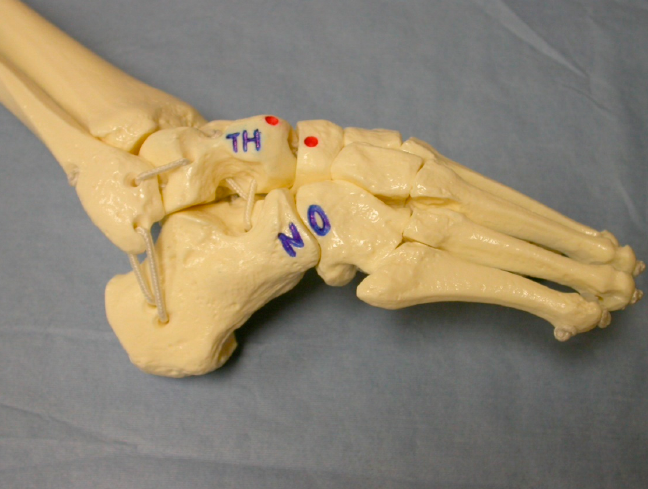
Figure 2. Ponseti foot model showing where to apply pressure on the lateral talar head (TH) and which area (calcaneocuboid joint) to be avoided (NO).